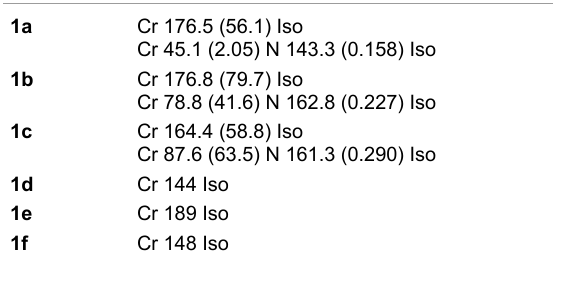
Table 1: Phase-transition temperatures (°C) of the compounds 1a – 1f , recorded for second heating (first row) and second cooling (second row) cycles at 10 °C/min from DSC and confirmed by polarized optical microscopy. The enthalpies ( ∆ H in kJ/mol) are presented in paren- theses.